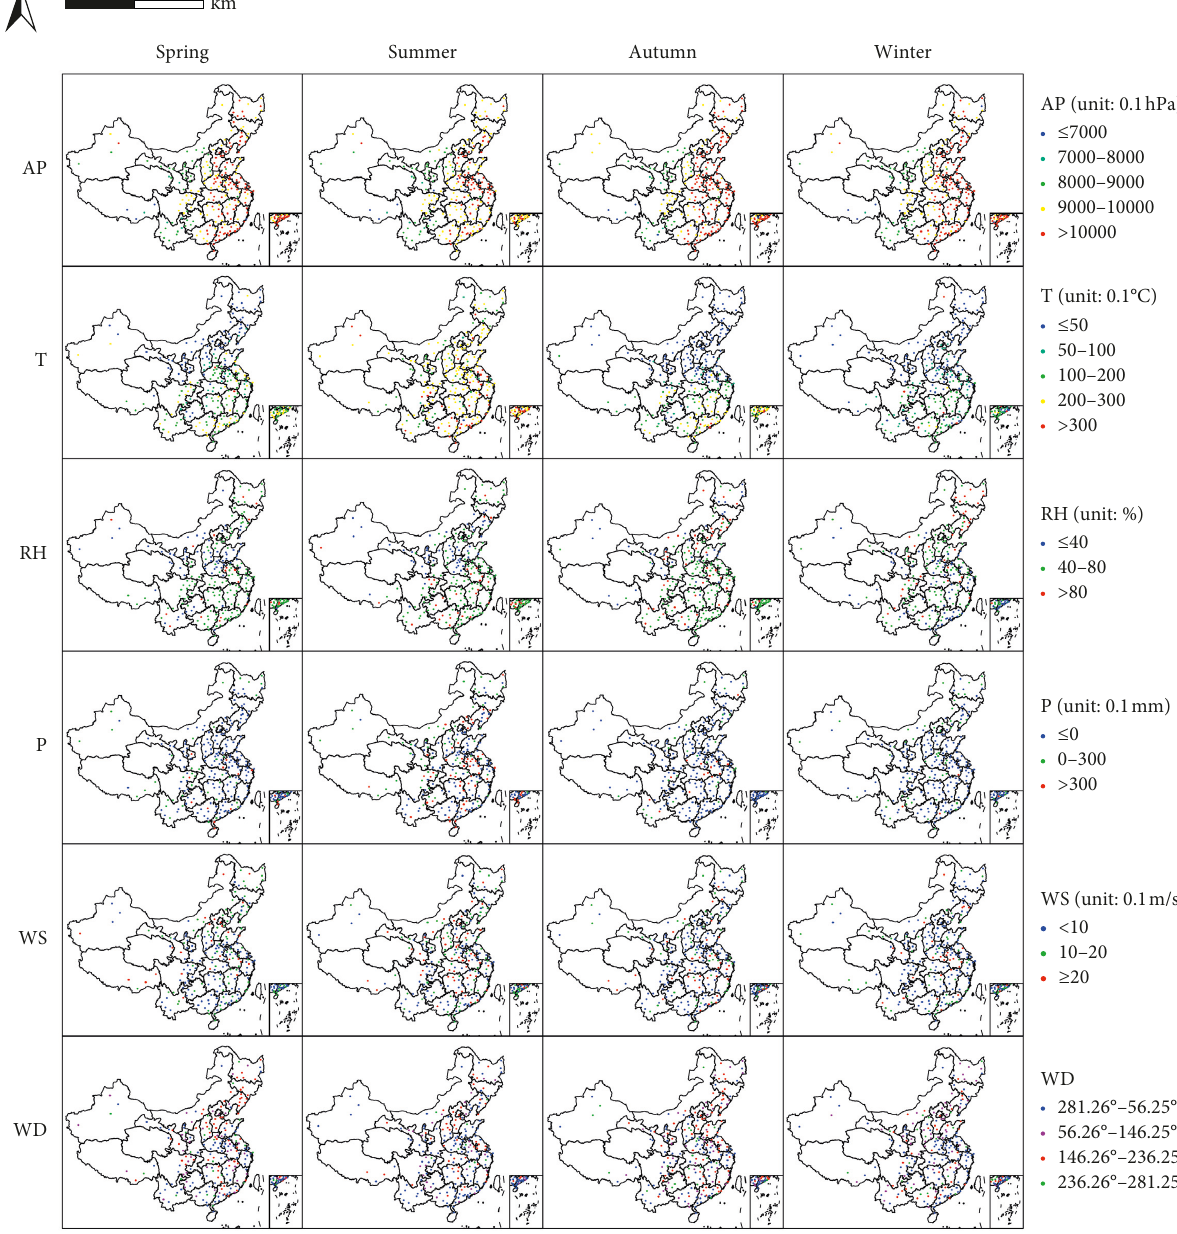
Figure 18: Spatial pattern of the impact of meteorological factors on SO